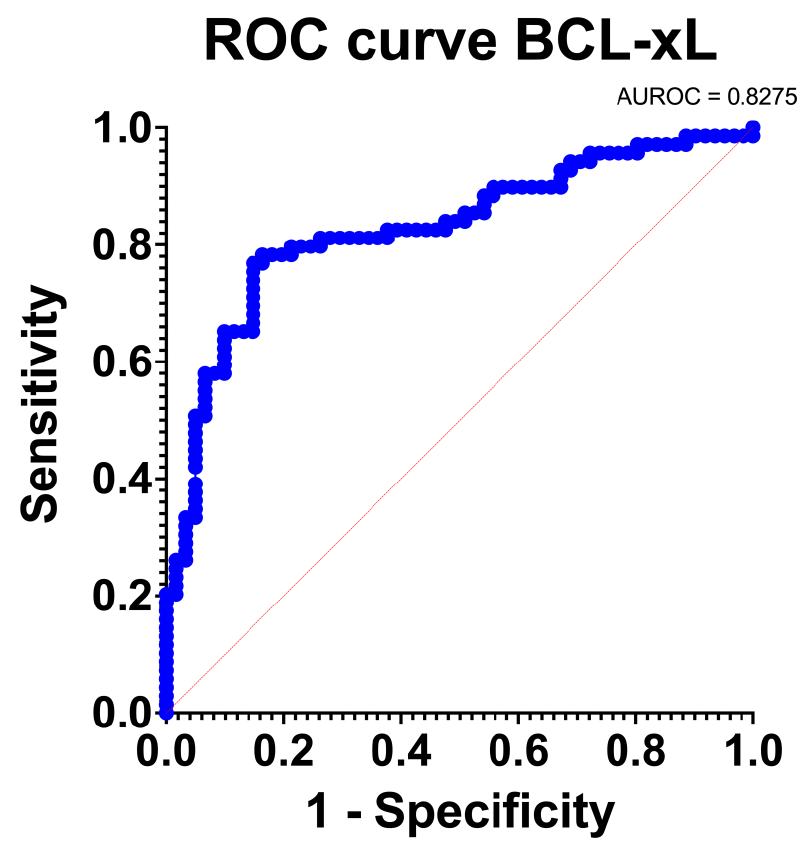
Figure 5. Receiver-Operating Characteristic (ROC) curve regarding the